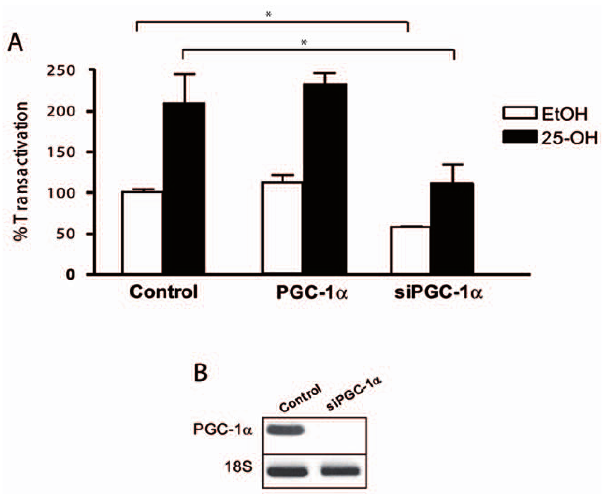
Figure 4. Implication of PGC-1 a in sPLA2-IIA promoter activity. A/ Implication of PGC-1 a in sPLA2-IIA promoter activity. 158N cells were transiently transfected with either 0.2 m g of sPLA2-IIA(1 kb), 0.1 m g of pRSV- b Gal plasmids with PGC-1 a expression vector, with mock vector or with a siRNA specifically directed against PGC-1 a , as indicated. Eighteen hours after transfection, cells were incubated with 25-OH (10 2 5 M) for 24 h, and then luciferase and b -galactosidase activities were analyzed. Results are expressed as percentage of the basal activity and they represent the mean + / 2 SEM of at least four independent experiments performed in duplicate. *p , 0.05 when compared between control cells and cells transfected with PGC-1 a expression vector or siRNA against PGC-1 a using Bonferroni’s test after ANOVA. B/ The efficacy of the siRNA was analyzed by RT-PCR. 158N cells were transiently transfected with a siRNA specifically directed against PGC- 1 a . 24 hours after transfection, total RNA was prepared. RT-PCR experiments were performed using primers recognizing specifically PGC-1 a . PCR products were analyzed on agarose gel (2%) and visualized under UV. 18S RNA was detected by specific primers and used to normalize PGC-1 a expression levels.